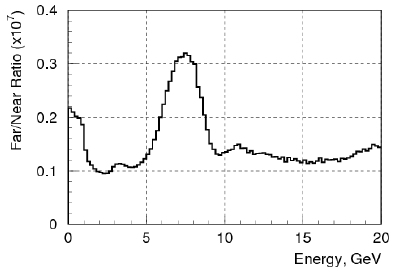
Figure 5. The ratio of the neutrino flux per square meter at the far detector (ORСA) to the flux per square meter at the near detector with an area of 2  2 m 2 .